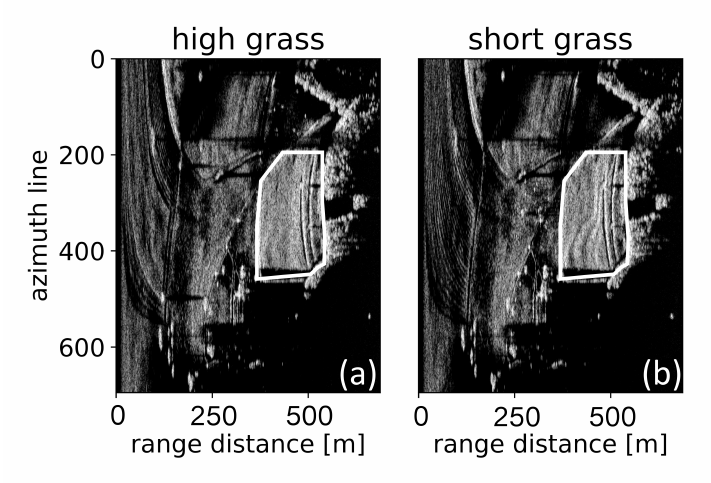
Figure 7. Measured MPI in the Hönggerberg test site with varying scattering properties. ( a ) high grass prevails in the near range (range distance less than 200m) and only a small area has been mowed, while, in ( b ), the entire field in the near range has been mowed and the remaining short grass results in strong specular reflection. In the observation area (range distance 400–500m), the MPI signal is much stronger when very short grass is